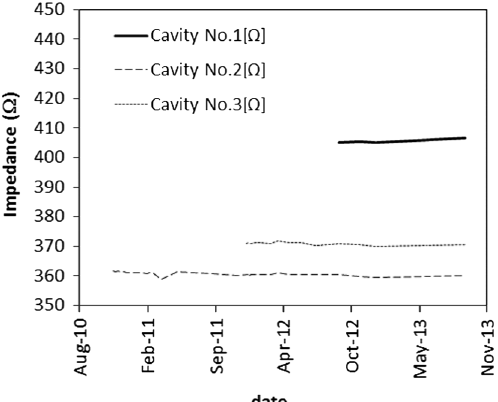
FIG. 10. Variation of the cavity impedance during machine operation. The cavity no. 1 (bold line), which has one cell using the FT3L core, has a higher impedance than the other cavities (dashed and dotted lines). It has been operated for a few months and the cavity impedance is as stable as the others.